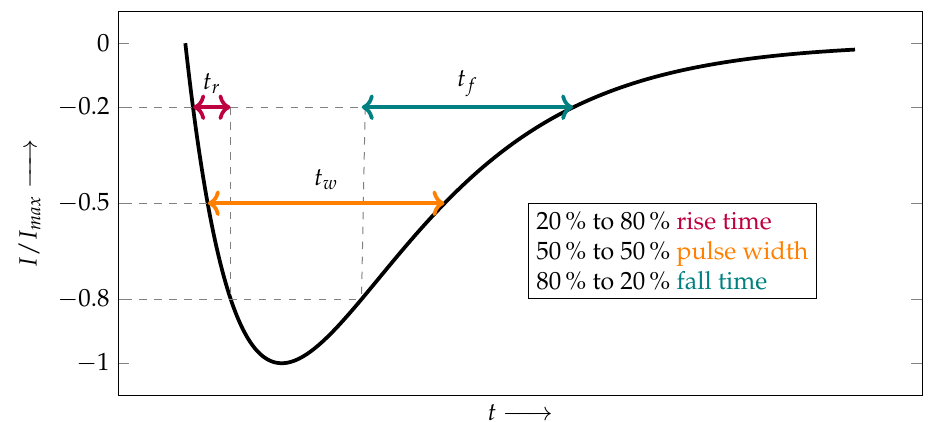
Figure 10. Pulse shape